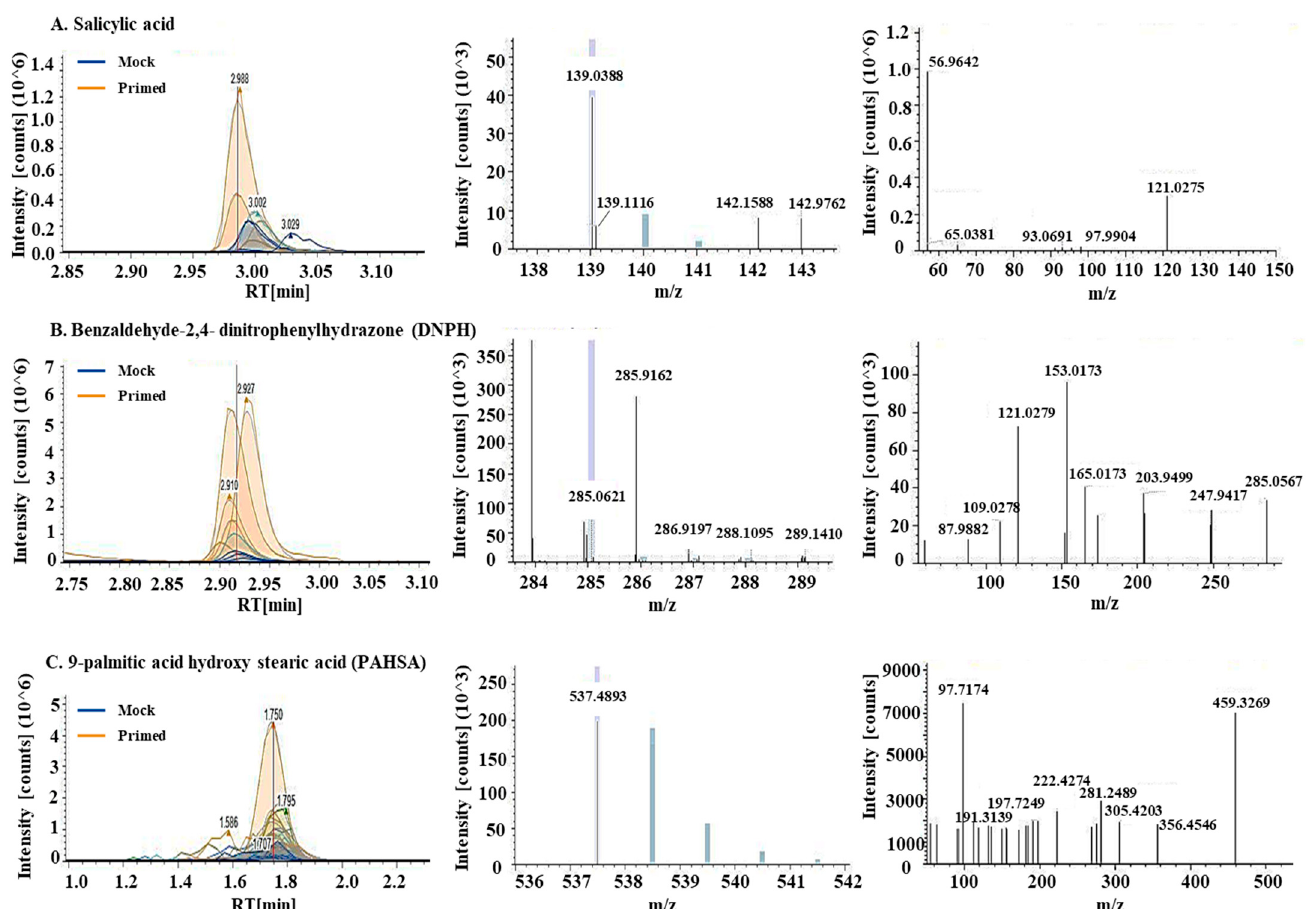
Figure 4. Metabolites involved in biotic stress response, lipid peroxidation, and a palmitic acid ester increased in the primed guard cells. Chromatograms, MS1, and MS2 spectra (from left to right) for ( A ) salicylic acid, ( B ) Benaldehyde-2,4-dinitrophenylhydrazone (DNPH), and ( C ) 9-palmitic acid hydroxy stearic acid (PAHSA). Chromatograms showed increases of these metabolites in the primed guard cells (orange lines) when compared to mock guard cells (blue lines). MS1 spectra for precursor ions and MS2 spectra for fragment ions allowed for quantification and identification of the metabolites.